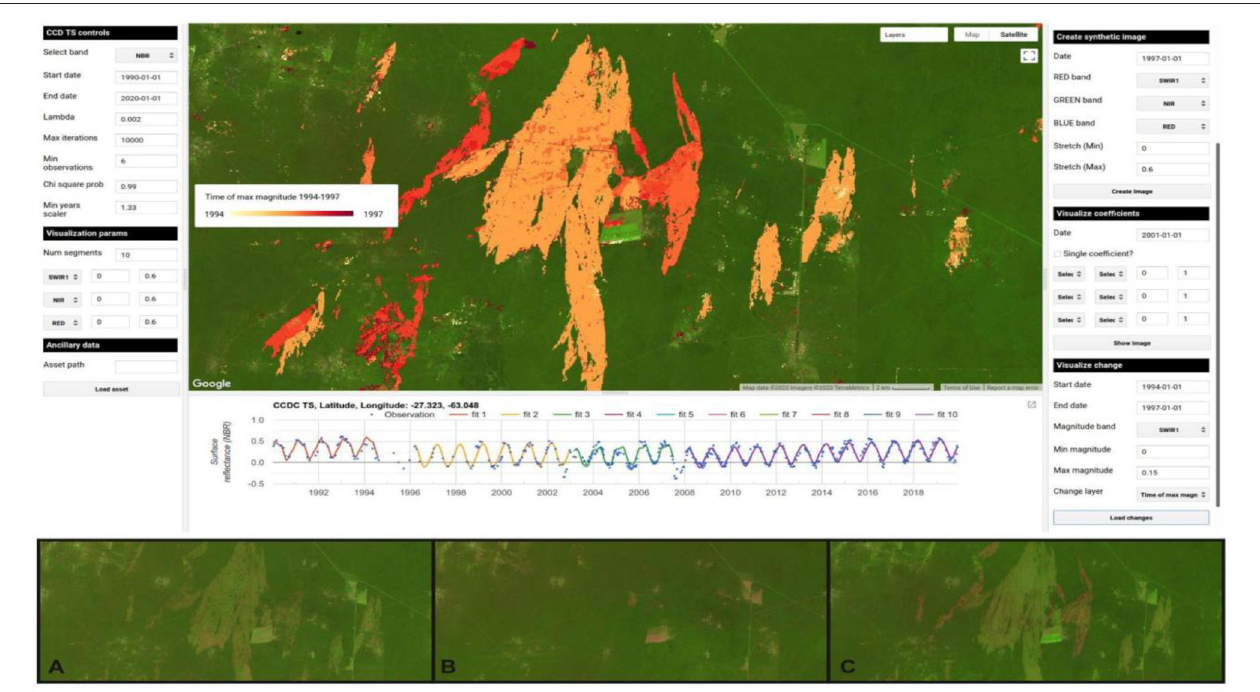
FIGURE 9 | Interface of the spatial data viewer (upper panel) showing the time of maximum magnitude of change between 1994 and 1997 in this area, revealing the timing of fire events. The change layer was created using the “Visualize change” section on the bottom of the right panel. The time series in the bottom panel are displayed following the settings on the left panel. Insets below the screenshot show: (A) The synthetic image for the first day of 1997; (B) A surface reflectance Landsat image prior to the fire even (1994-02-07), loaded by clicking on the corresponding observation in the time series chart; (C) a surface reflectance Landsat image after the fire event (1996-03-16) loaded in the same way as the prior image. Images are shown in RGB color combination corresponding to the SWIR1, NIR, and Red bands, respectively, as set in the “Visualization params” section on the left